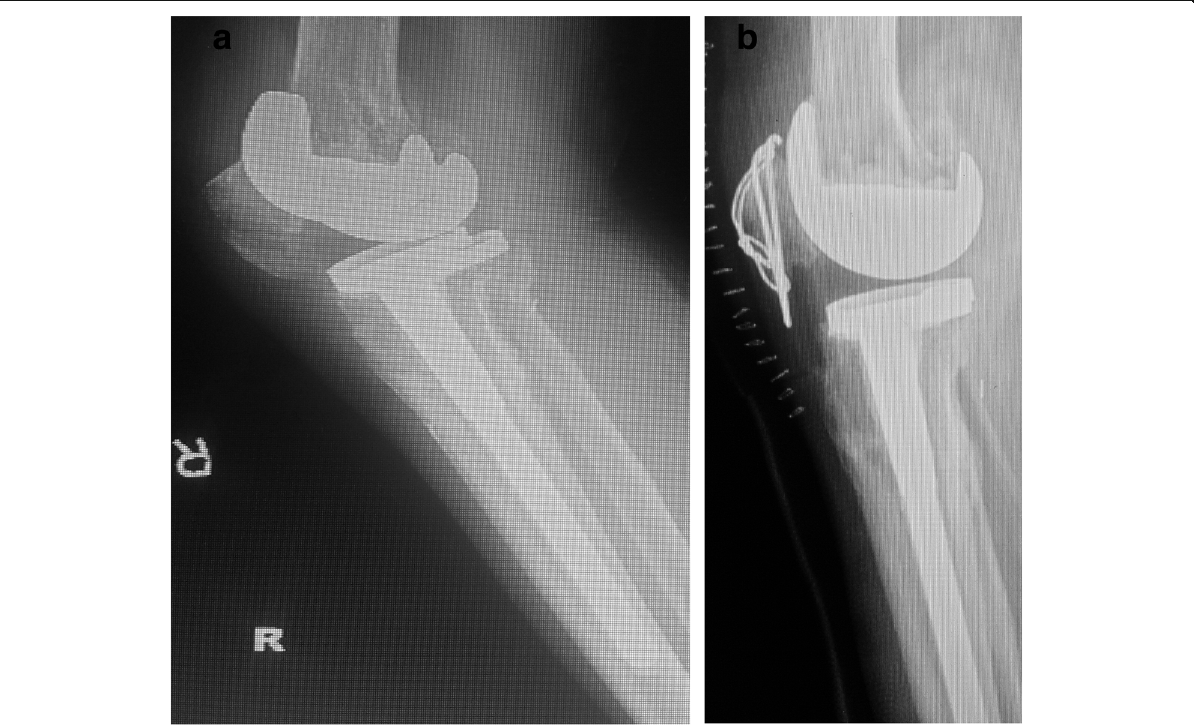
Fig. 3 A 72-year-old women who suffered a PPPF (case 3 in Table 1). a Preoperative lateral view showing a posterior stabilized system (Depuy) with stem extender. b The displaced inferior pole fracture is fixed with tension band